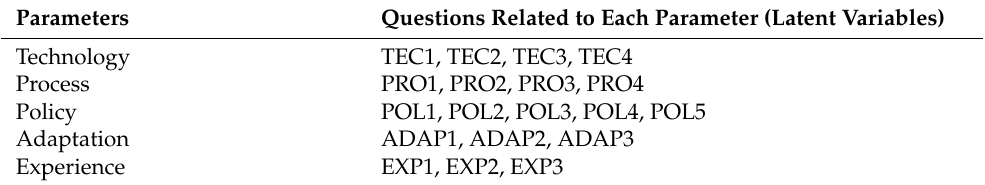
Table 4. Latent variables considered in the model. Parameters Questions Related to Each Parameter (Latent